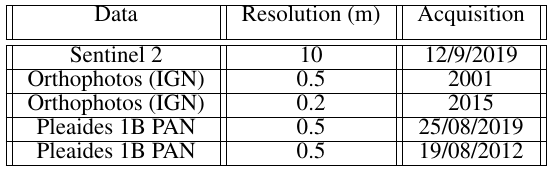
Table 1. Datasets used for the